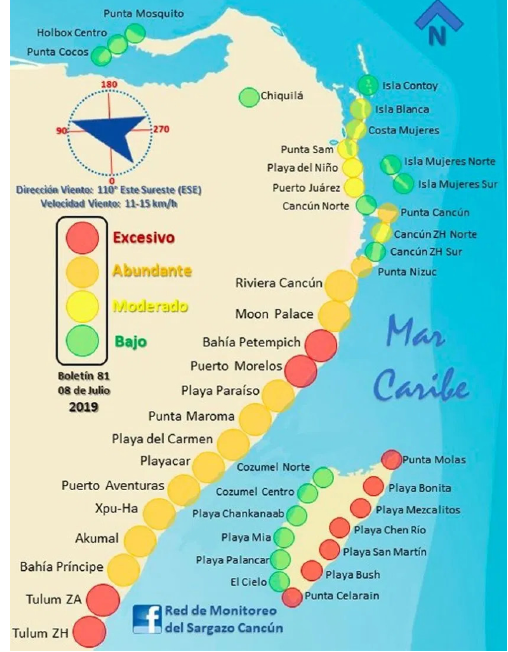
Figure 3: Map of Caribbean beaches with sargassum (red) from Sargassum Monitoring Network, cited in Mexican News Daily, July 3, 2019